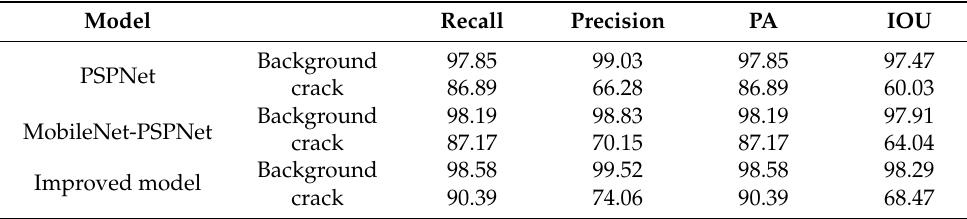
Table 3. Results of different models for training.